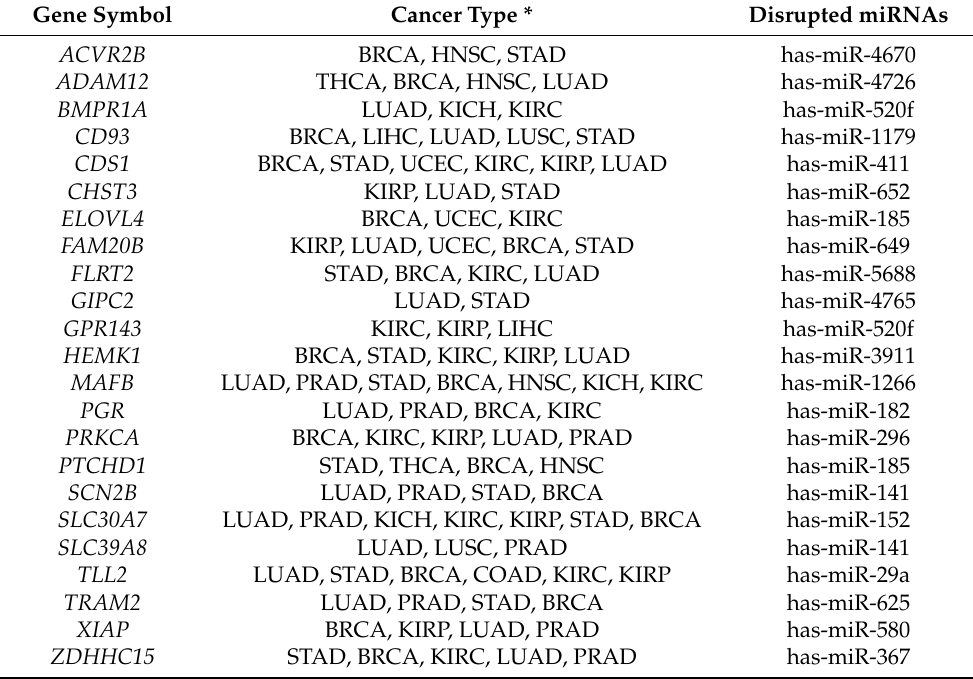
Table 1. Genes harboring 24 variants and their associated TCGA(The Cancer Genome Atlas) cancer types with disrupted